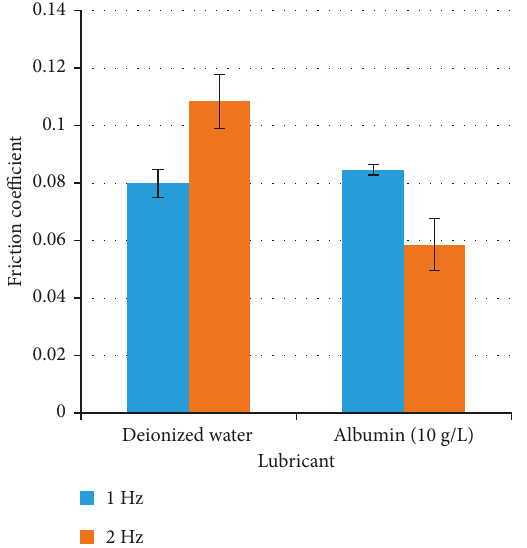
Figure 7: Effect of speed under 3 N load condition.